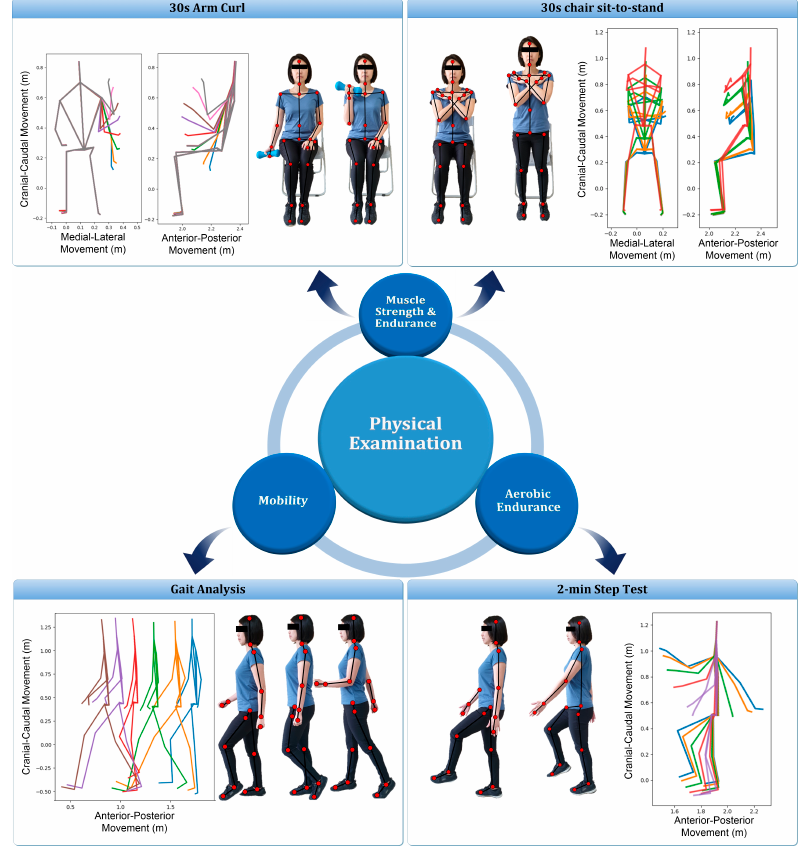
Figure 2. Illustration of the four functional assessment tests. For each test, multiple time frames of the skeleton pose were depicted from the acquired Kinect data of the present study.